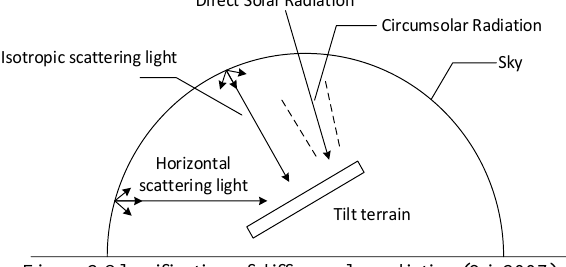
Figure 2.Classification of diffuse solar radiation (Qi, 2007) As shown in Figure 2, the radiation sources that affects the soft shadow can be divided into three; circumsolar radiation, isotropic scattering and horizontal brightening (Ur Rehman, 2015). Because the aerosols have a strong forward scattering component, a substantial portion of the aerosol-scattered diffuse radiation appears to come from a small annular area around the solar disk; this radiation is called circumsolar radiation, which has the maximum radiation. The assumed isotropically